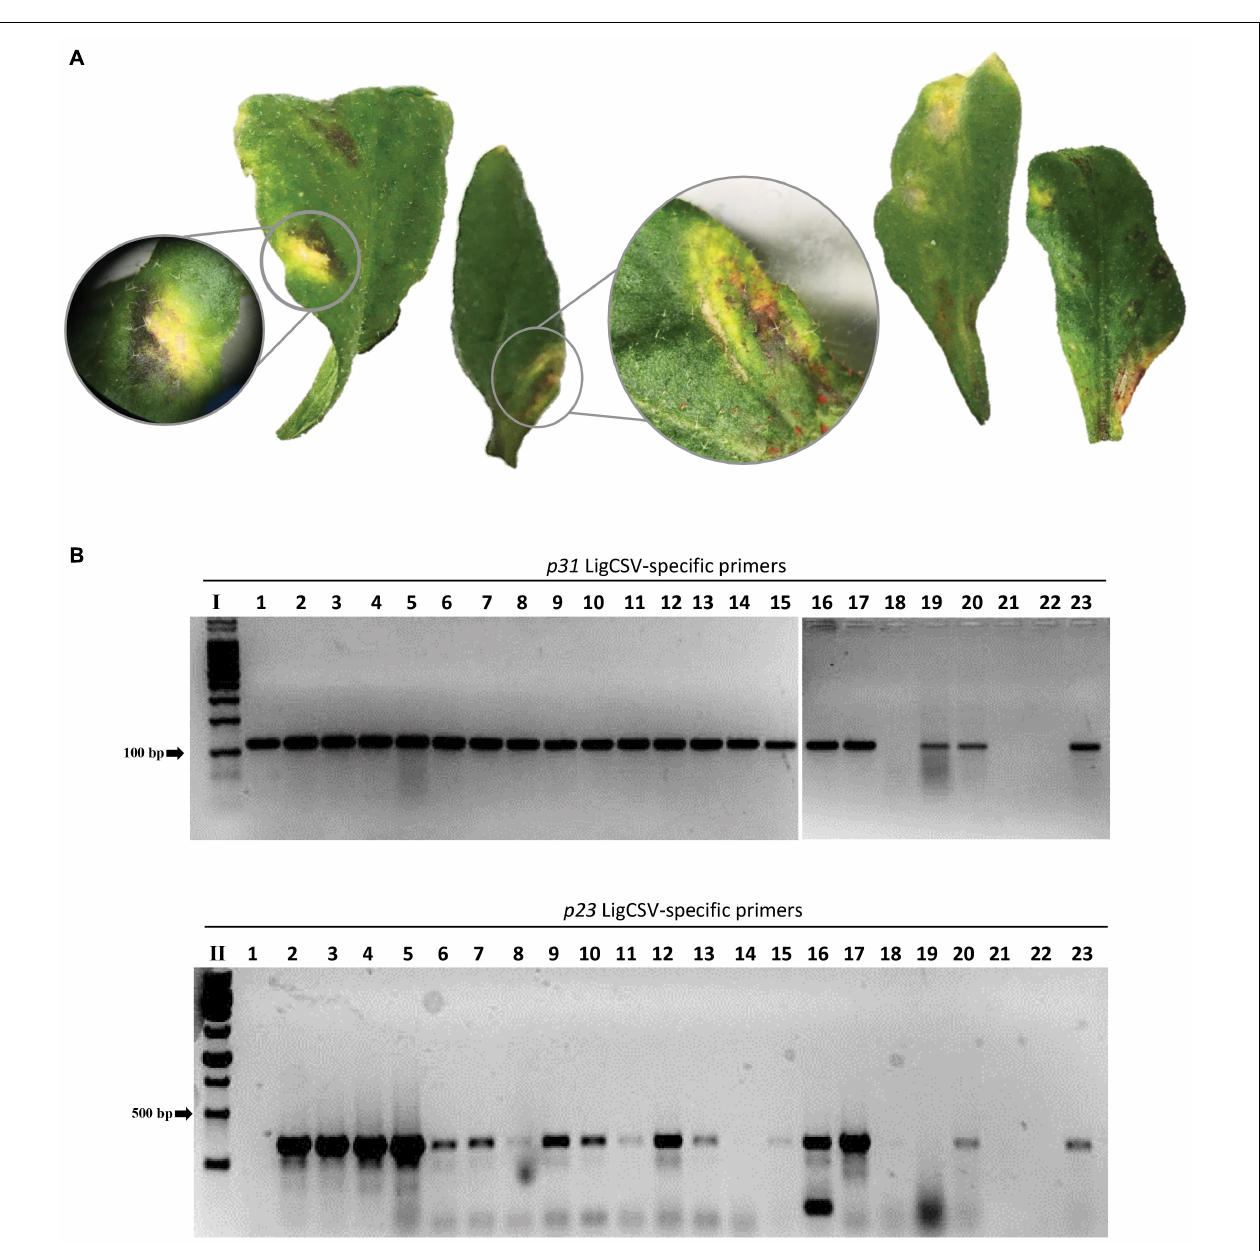
FIGURE 6 | Experimental transmission of Ligustrum chlorotic spot virus (LigCSV) to healthy Arabidopsis thaliana plants using viruliferous Brevipalpus papayensis mites. (A) Arabidopsis leaves showing chlorotic and necrotic lesions after 7 days of infestation with Brevipalpus papayensis found in symptomatic Ligustrum japonicum plants infected with LigCSV, collected in São Paulo, SP, Brazil. (B) 1% agarose gel electrophoresis of RT-PCR products for the specific detection of LigCSV RNA1 (primer pair p31 , expected amplicon size: 123 bp) and LigCSV RNA2 (primer pair p23 , expected amplicon size: 420 bp) of LigCSV. I: Molecular weight marker, 100 bp DNA Ladder (Promega, Madison, WI, United States); II: Molecular weight marker, 1 kb DNA Ladder (Promega). Lanes 1–20: Selected symptomatic individual lesions from mite-infested arabidopsis plants; lane 21: Reverse-transcription reaction negative control; lane 22: PCR negative control; and lane 23: LigCSV-infected Ligustrum japonicum plant, positive control of the RT-PCR tests.